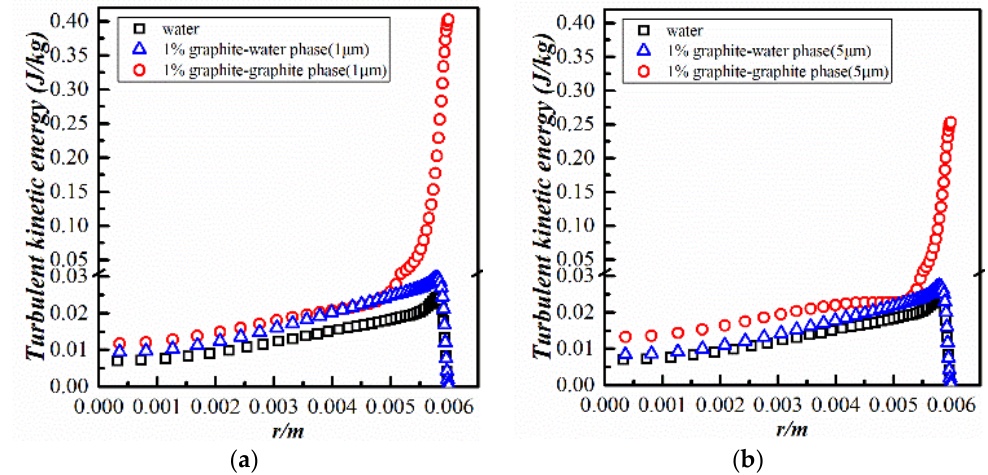
Figure 13. The turbulent kinetic energy in the middle cross-section of the tube at Re = 23,000: ( a ) a graphite particle size of 1 μ m with a volume fraction of 1.0% ; ( b ) a graphite particle size of 5 μ m with a volume fraction of 1.0% .